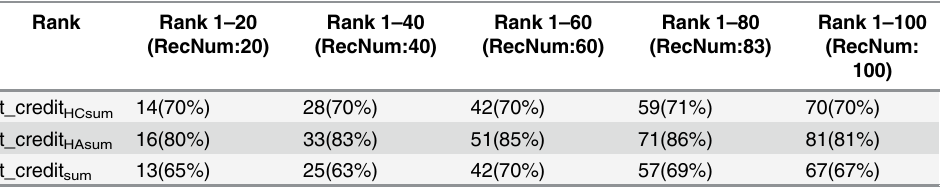
Note: The segments are not separated evenly because tied ranking cases are not uncommon in